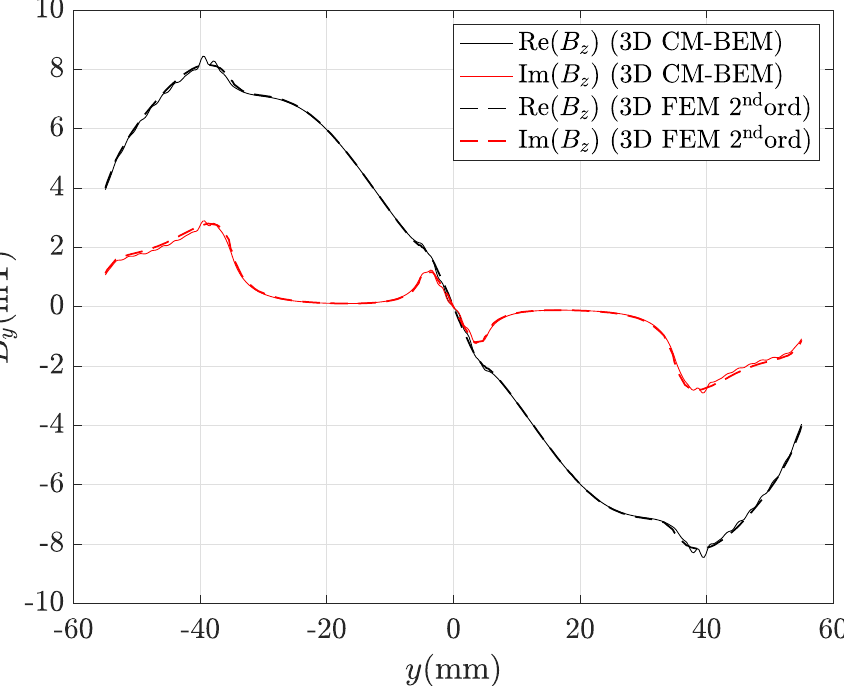
Figure 11. Real and imaginary parts of the magnetic flux density radial component B y along line AB in Figure 8 computed by the hybrid method (R-SVD matrix compression) with the coarsest mesh (69,492 tets): CM-BEM is the straight line, second ord. 3D FEM (reference) is the dashed